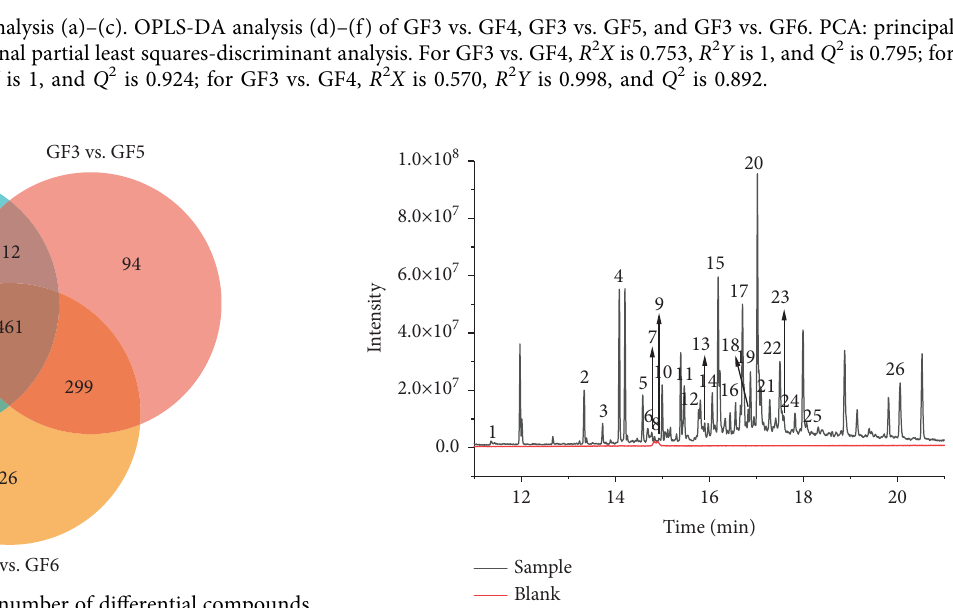
Figure 4: Te total ion chromatogram (TIC) of the 26 identifed common diferential compounds. Number 1 – 26 represents 26 identifed common diferential compounds by NIST 11 in